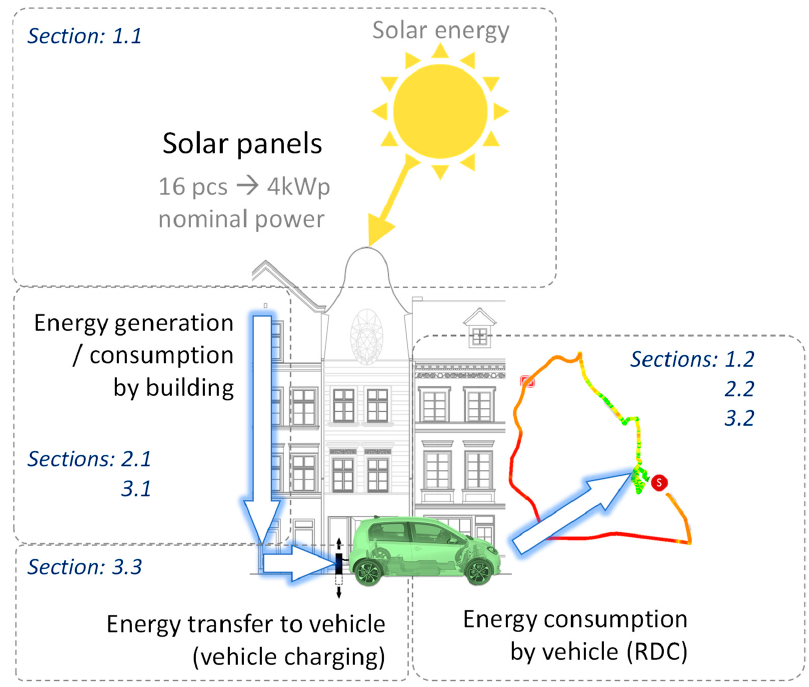
Figure 6. Range of conducted analyses with description of their location in the